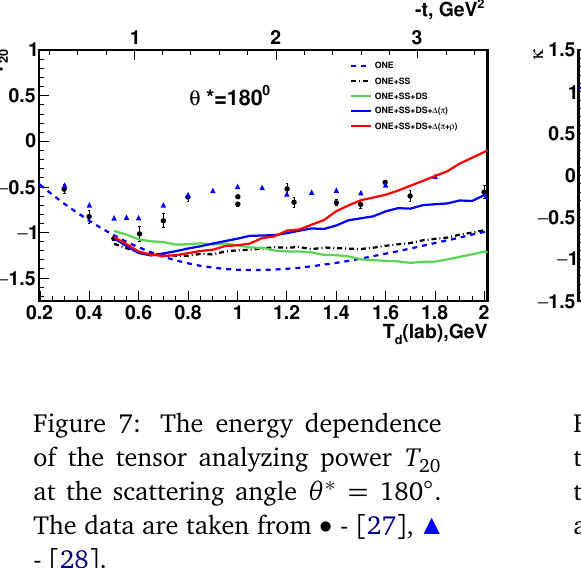
Figure 8: The energy dependence of the polarisation transfer at the scat- 20 tering angle θ ∗ = 180 ◦ . The data are taken from [ 28 ]